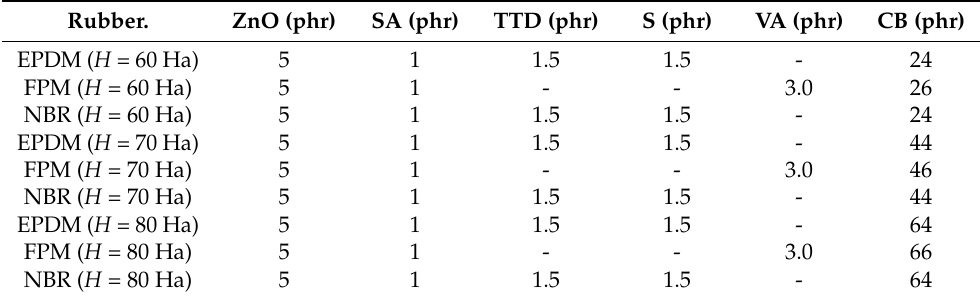
Table 2. Basic compositions of EPDM, FPM, and NBR rubbers (phr—parts per hundred rubber).